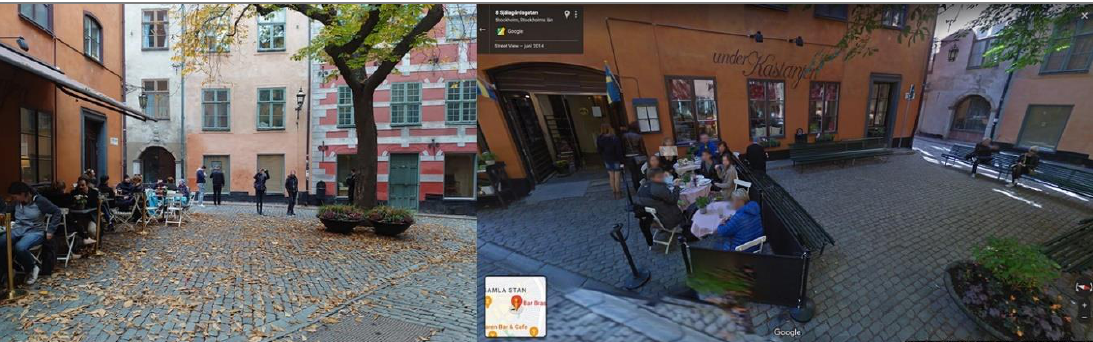
Figure 3 The outdoor dining area in a contemporary image (October 30, 2021) and the arrangement in 2014 (Google Streetview) showing the replacement of public benches by the outdoor serving of Under Kastanjen. Photograph by the Author and from Google (© Google 2014).